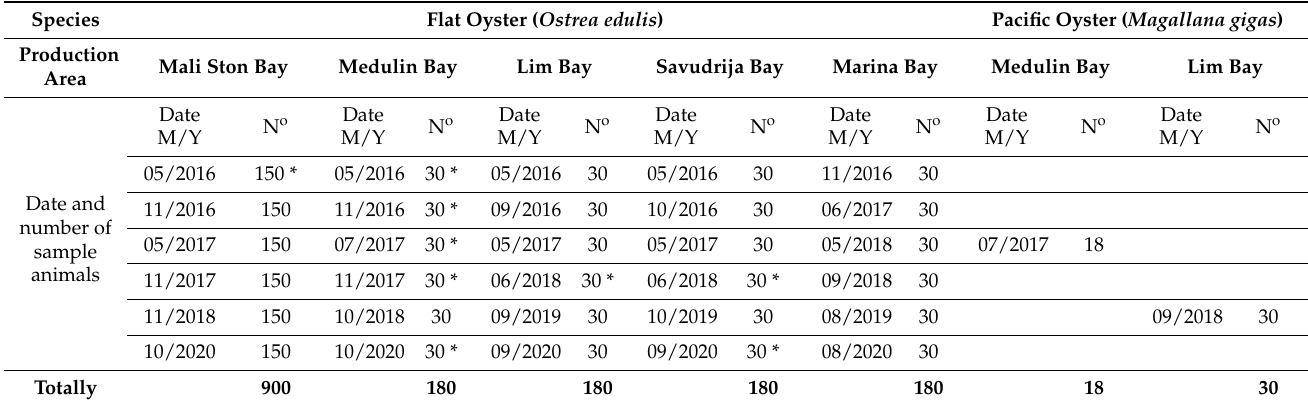
Table 1. Positive findings of Bonamia exitiosa within sampling area showing sampling dates, sampling points, and prevalence using different diagnostic techniques in Croatia during the period 2016–2020.